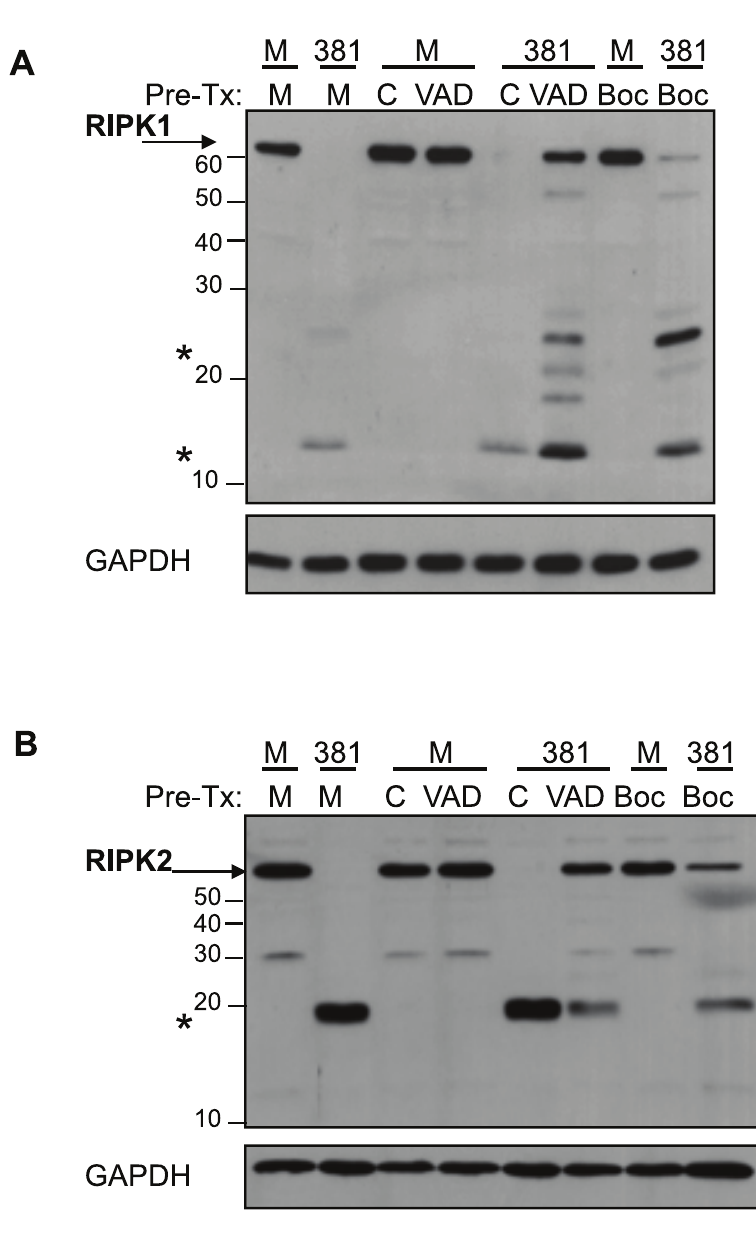
Figure 5. General caspase inhibitors z-VAD-FMK and Boc-D-FMK alter P.gingivalis -induced modification of RIPK1 and RIPK2 in HUVEC. HUVEC were pretreated (Pre-Tx) with medium ( M ), 0.25% DMSO vehicle control ( C ), 25 m M z-VAD-FMK ( VAD ), or 100 m M Boc-D-FMK ( Boc ) with for 1.5 h. HUVEC were then treated with medium ( M ) or P. gingivalis strain 381 (MOI 100, 381 ) for 2 h. Whole cell lysates were analyzed for ( A ) RIPK1 or ( B ) RIPK2 and GAPDH. Full-length RIPK1 and RIPK2 are indicated with arrows. Prominent P. gingivalis -induced LMW bands are indicated with asterisks. MW ladder is indicated on the left in kDa.